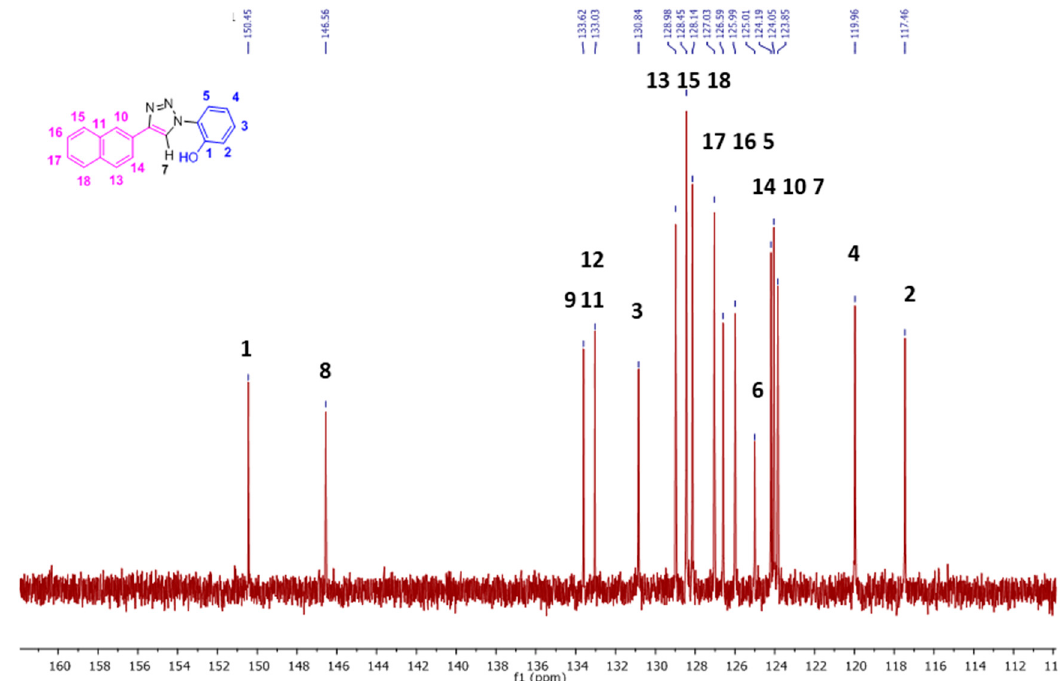
Figure 4. The 13 C-NMR spectrum (100 MHz, (CD 3 ) 2 S=O, RT) showing the expansion from δ 110–162 ppm of NpTP . (For the full version, see Figure S2.)